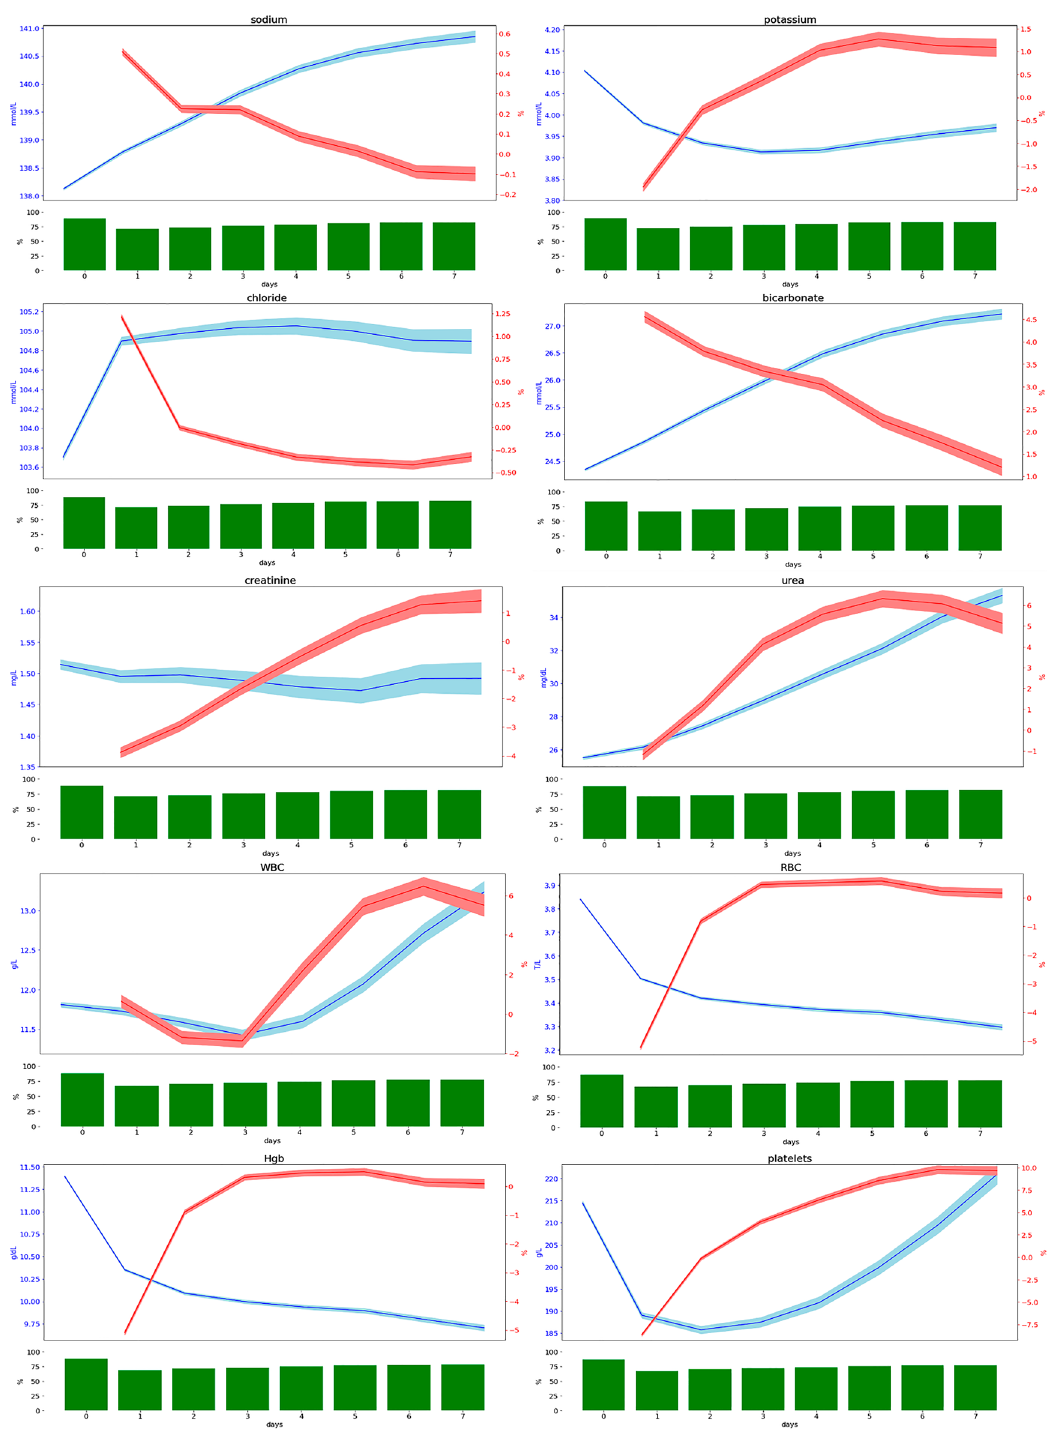
Figure 1. Proportion of patients who underwent at least 1 test on a single day out of all patients in intensive care unit on that day (green histogram), test results (blue curve), and daily variations in test results (red curve). WBC, white blood count; RBC, red blood count: Hgb, For all parameters, daily variations in test results decreased over time during the ICU stay, with the excep- tion again of urea. Some laboratory parameters were more finely regulated than others. Thus, daily variations in sodium levels were less than 0.5% compared to daily variations of up to 10% for platelet count. Figure 1 shows the proportion of patients who underwent at least 1 test on a single day out of all patients in ICU on that day (green histogram) along with test results (blue curve) and daily variations in test results (red curve). The line thickness represents confidence intervals.